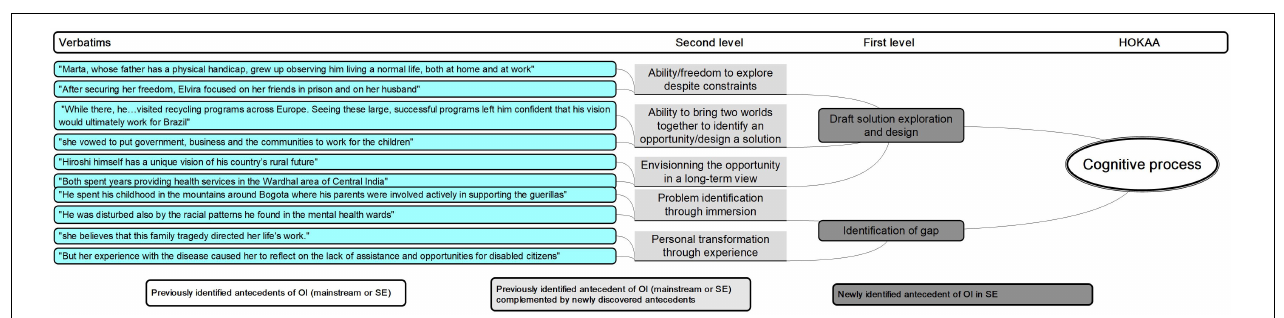
FIGURE 6 | HOKAA ‘Cognitive process’: emerging